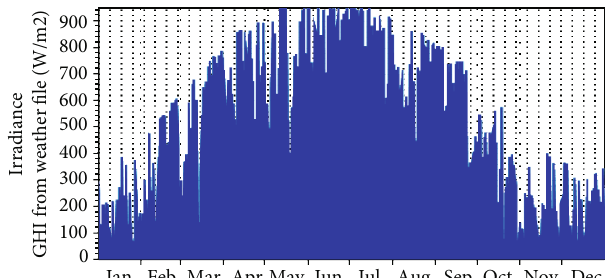
Figure 18: Time series data of GHI.